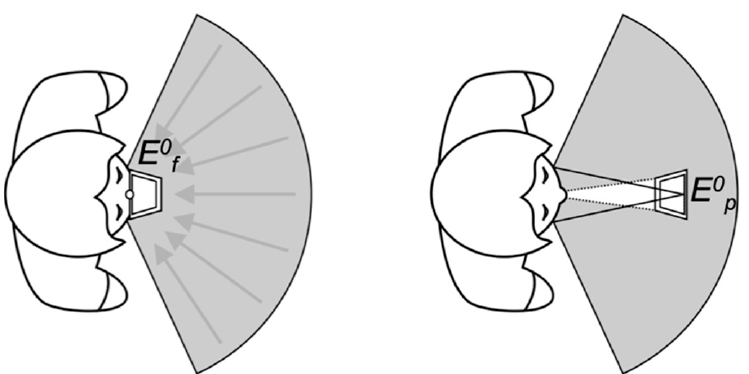
Figure 2. Device calibration method. The light sensor of the device is placed near the eyes and facing forward to measure illuminance of the face ( E f ) ( left ). The device is then placed at a typical viewing distance in front of the eye (30 cm) and the illuminance calculated at the camera CCD is measured ( right ).